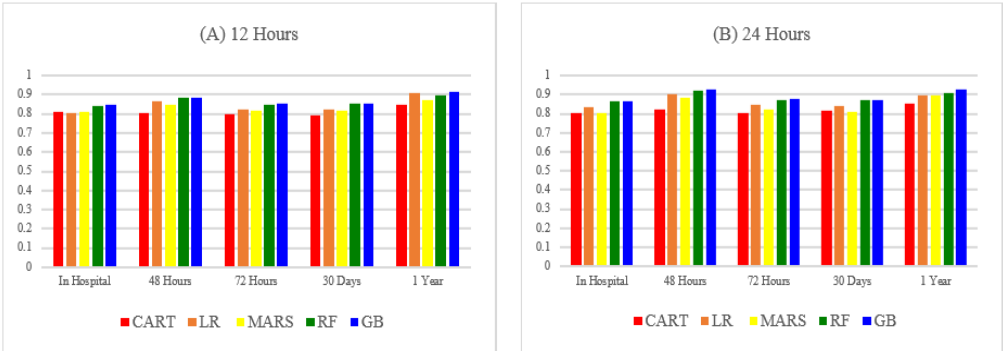
Figure 4. The AUROCs of different classifiers ( A ) based on 12 h dataset ( B ) based on 24 h dataset.